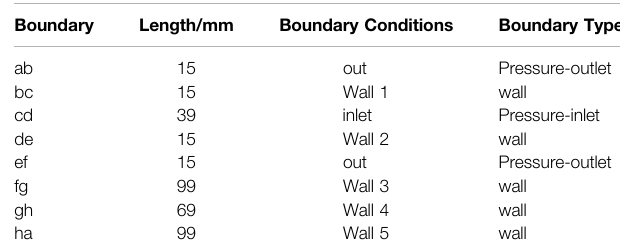
TABLE 1 | Calculation model and boundary